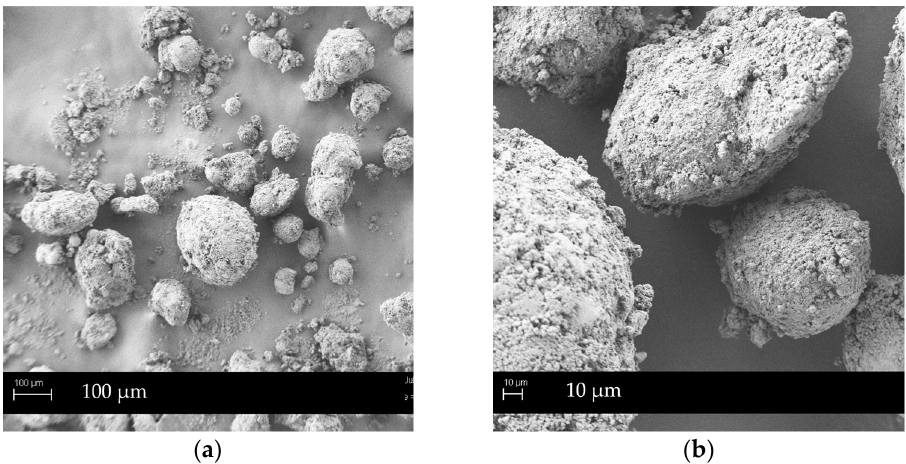
Figure 2. SEM images of G m NEU: ( a ) under magnification 200×; ( b ) under magnification 1000×.